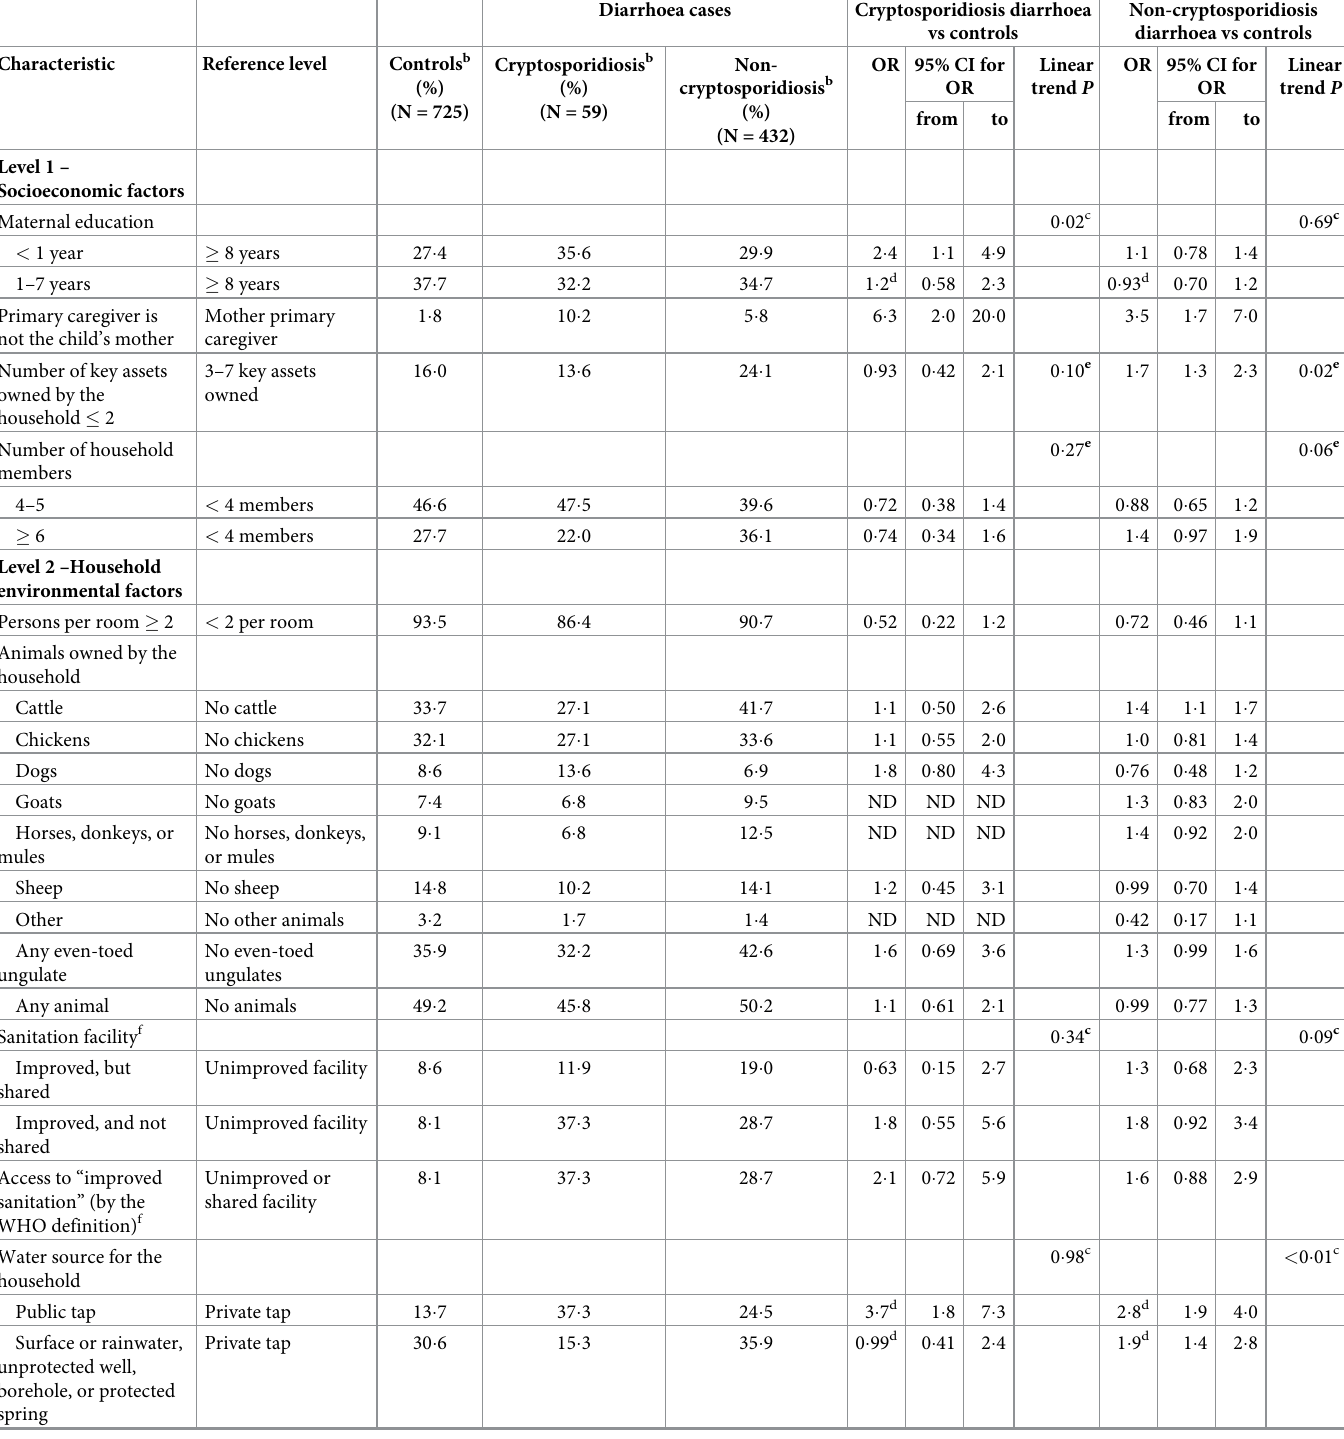
Table 2. Risk factors for cryptosporidiosis diarrhoea and non-cryptosporidiosis diarrhoea in children under 2 years old, compared with non-diarrhoea controls; odds ratios estimated from univariable models a